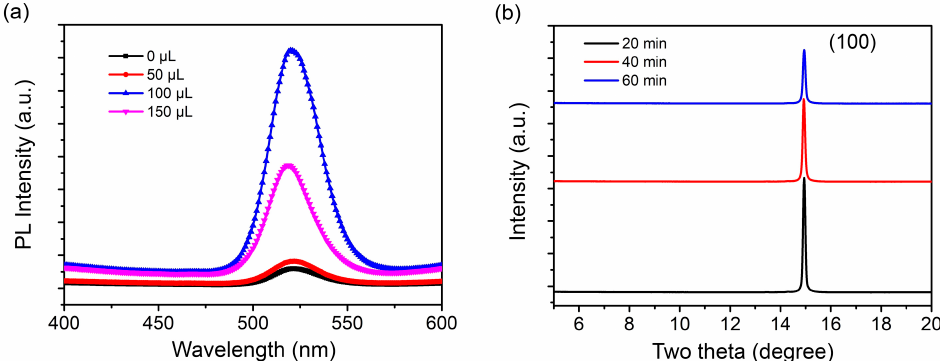
Figure 3. The PL spectra ( a ) of CH 3 NH 3 PbBr 3 films with different volumes of anti-solvent CB and XRD patterns ( b ) of CH 3 NH 3 PbBr 3 films with different annealing times.